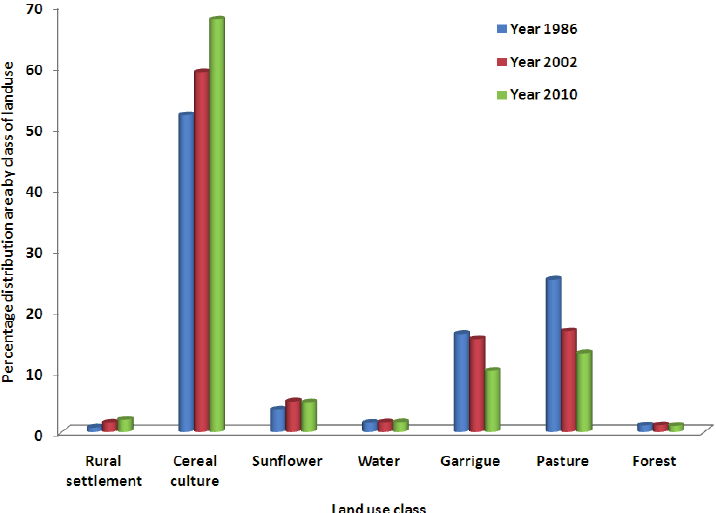
Fig. 3 Evolution of land use in the Joumine basin from 1986 to 2010.